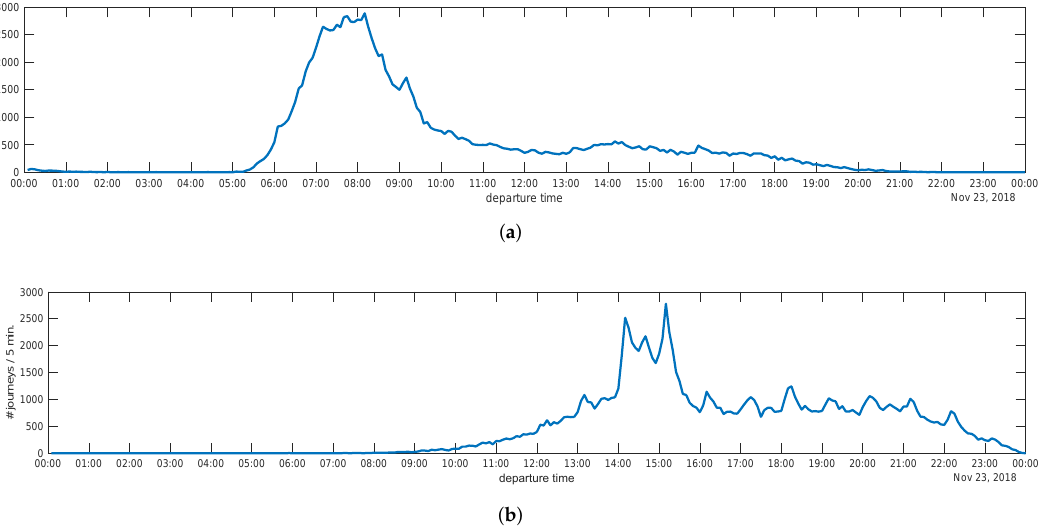
Figure 4. Number of journeys depending on the time of departure (23 November 2018): ( a ) outbound journeys; ( b ) return